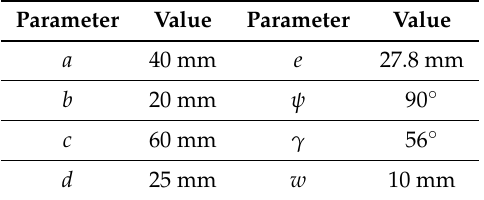
Table 1. Values of the parameters of the kinematic model of the underactuated gripper described in Figure 2. Parameter